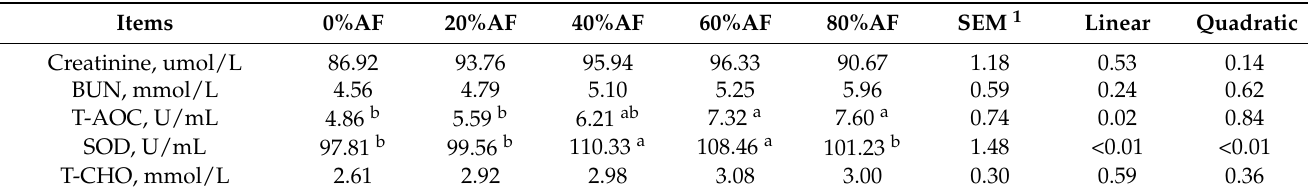
Table 2. The effects of alfalfa–sweet sorghum (AF–SS) silage-based diets on physiological status in blood of Karakul lambs.